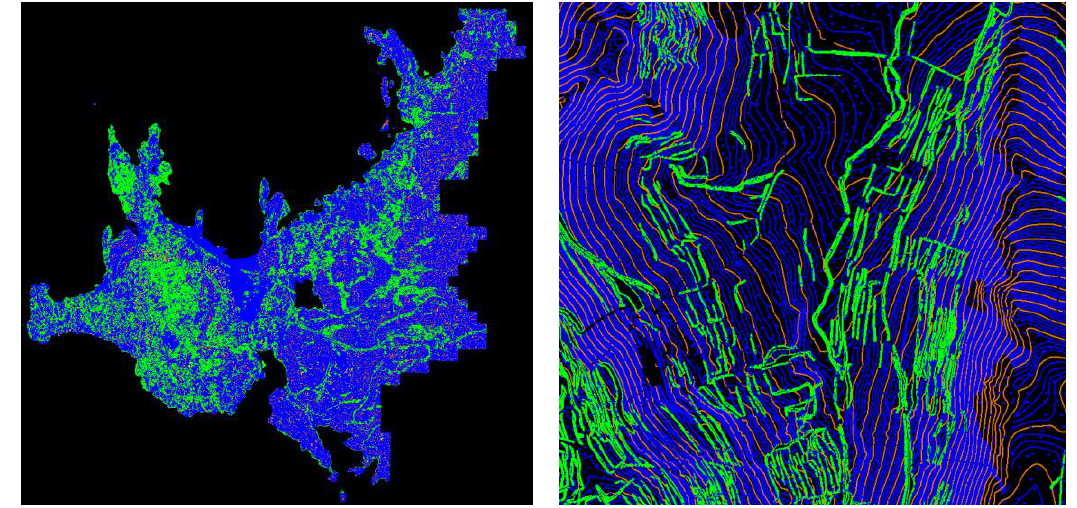
Figure 8. General view of the manually extracted terrain features ( left ) and close view ( right ). Within the photogrammetric flight project, contour lines with different intervals (i.e., 1 m, 2 m, 5 m, 10 m), breaklines and grid DTM points have been manually measured using Bentley MicroStation software by photogrammetry operators. More than 1.2 million height points, and thousands of contour lines and break lines have been merged and converted into a TIN dataset and a single DTM with 1-m grid interval (Figure 9).